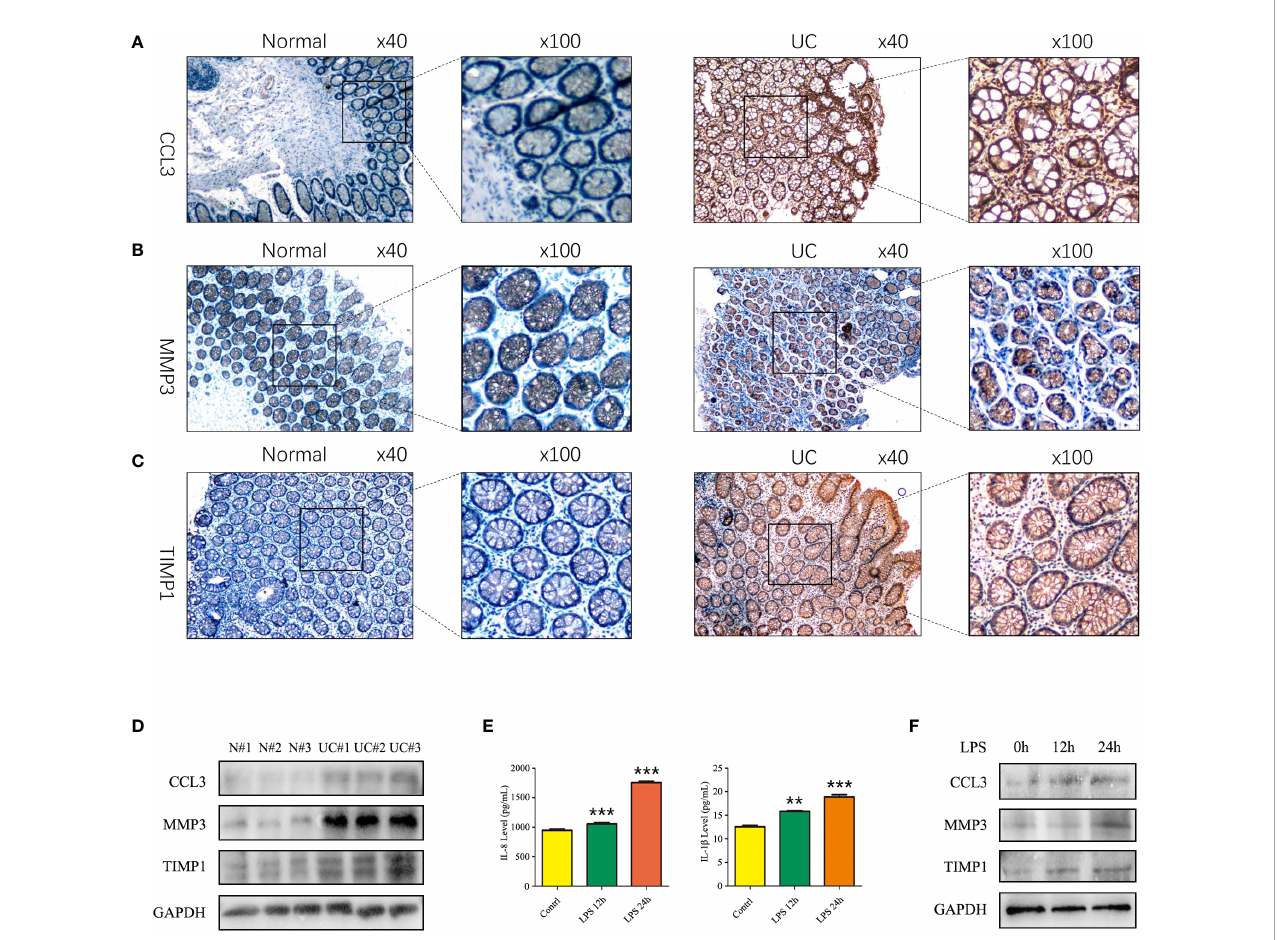
FIGURE 5 Expression of CCL3, MMP3, and TIMP1 in UC patients and induced enteritis cells. (A) The expression of CCL3. (B) The expression of MMP3. (C) The expression of TIMP1. (D) The protein expression levels of CCL3, MMP3 and TIMP1 in UC patients and healthy controls. (E) The in fl ammatory factors IL-8 and IL-1 b secretion level after 1 ug LPS stimulated NCM460 cells for 0h, 12h and 24h. (F) The protein expression levels of CCL3, MMP3 and TIMP1 in NCM460 cells stimulated with LPS for 0h, 12h and